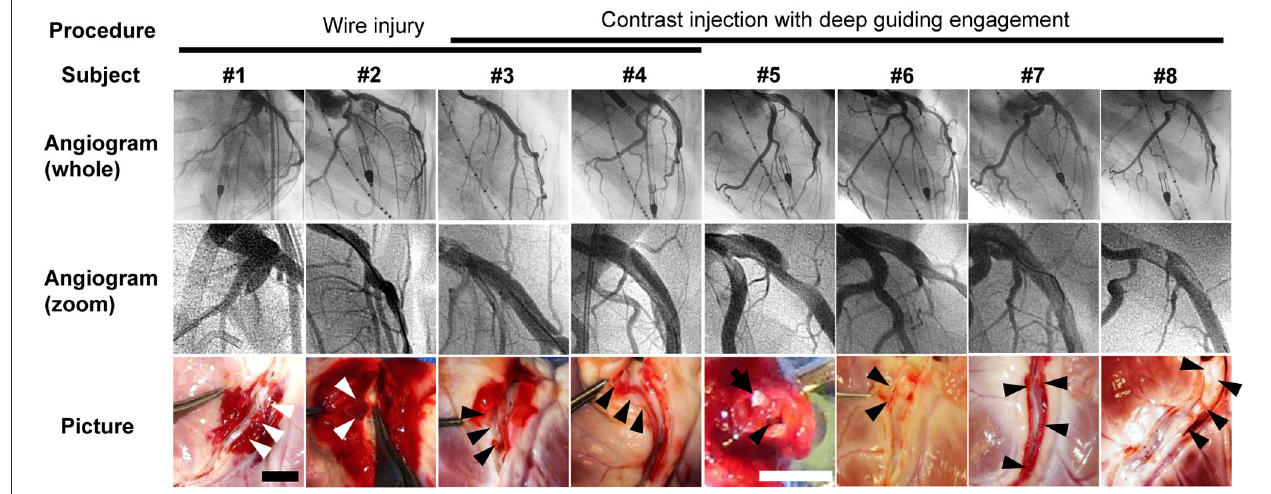
FIGURE 2 | Angiograms and postmortem pictures of all animals. Procedure for creation of coronary dissection is indicated on the top. Left coronary angiograms were taken after the creation of coronary dissection of the left anterior descending artery (LAD). Angiogram #1 was taken from the left anterior oblique 30 ◦ view. Angiograms #2–#8 were from the right anterior oblique 90 ◦ view. Zoomed angiograms show coronary dissections in LAD. The bottom images are postmortem pictures of the LAD cut open longitudinally (#1–#4 and #6–#8) or cross-sectionally (#5). Arrowheads (white and black) indicate dissected lumen. White arrowheads indicate relatively limited dissections with periarterial hematoma. Black arrowheads indicate dissections with smooth internal surfaces and surrounding hematoma. No evident re-entry was seen in any of the animals. In Picture #5, a 24-gauge cannula (a white tip) is placed in the true lumen (black arrow). Scale bars of the pictures are 10mm (black, #1–#4 and #6–#8) and 5mm (white, #5). LCA, left coronary artery.